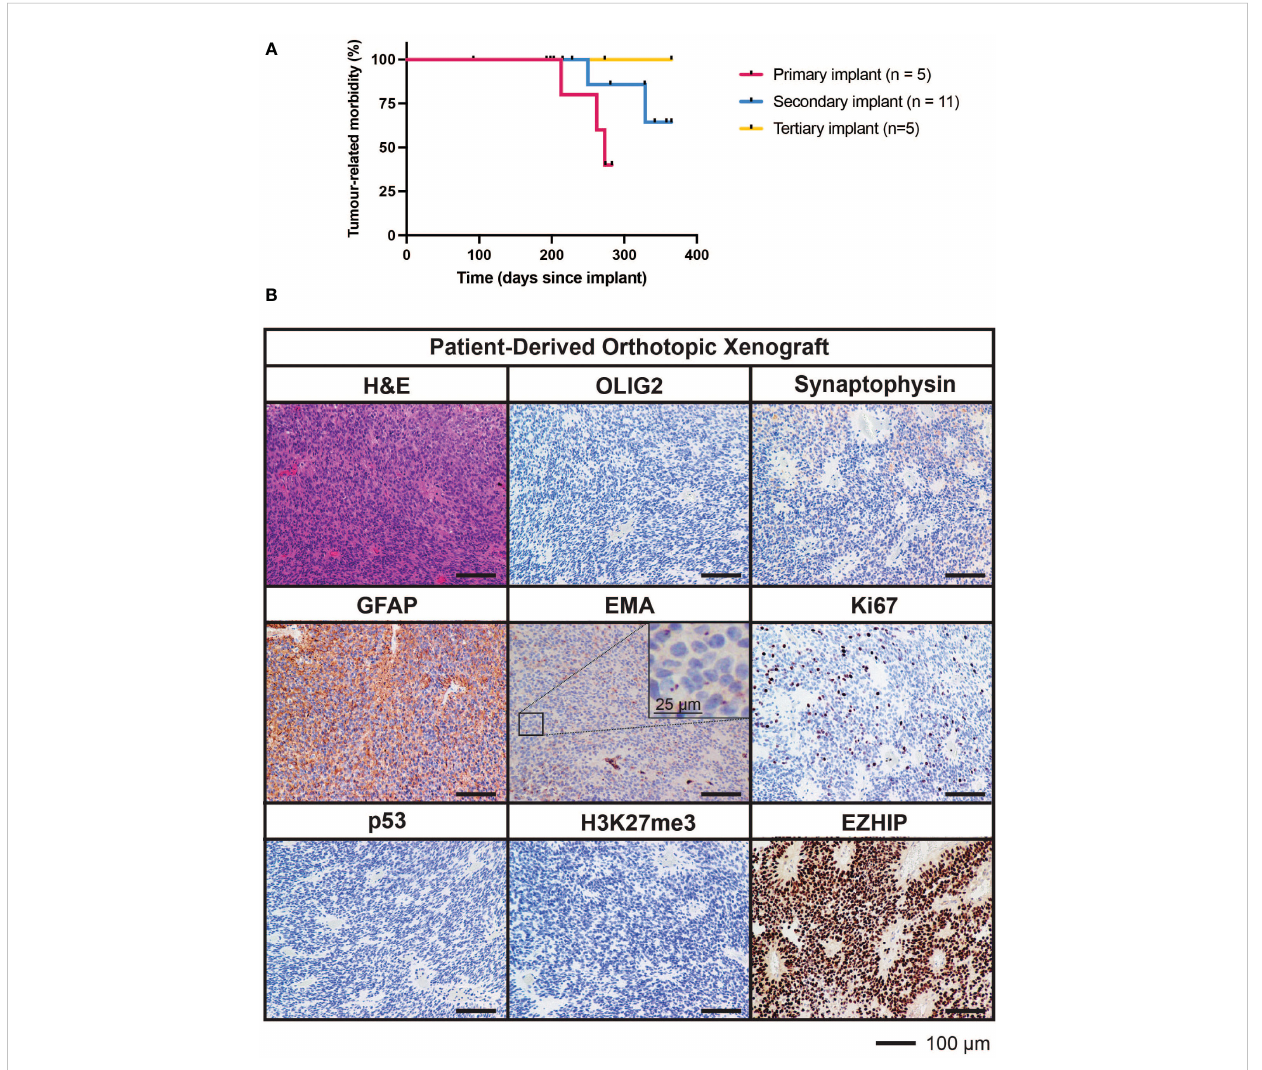
FIGURE 5 Survival characteristics and histological features of TK-EPN862. (A) Time to morbidity in the TK-EPN862 PDOX model. Mice were implanted with tumor cells from the fourth surgical sample (primary implant, pink ), or serially transplanted with TK-EPN862 cells (secondary implant, blue ; tertiary implant, yellow ). Mice euthanized for non-tumor-related reasons were censored (black vertical dash). (B) H&E staining (top left) or IHC for the indicated antibodies ( brown ) demonstrate that TK-EPN862 xenografts recapitulated the histological features of the matched surgical sample. Sections are counterstained with hematoxylin ( blue ) and the sizes of the scale bars are